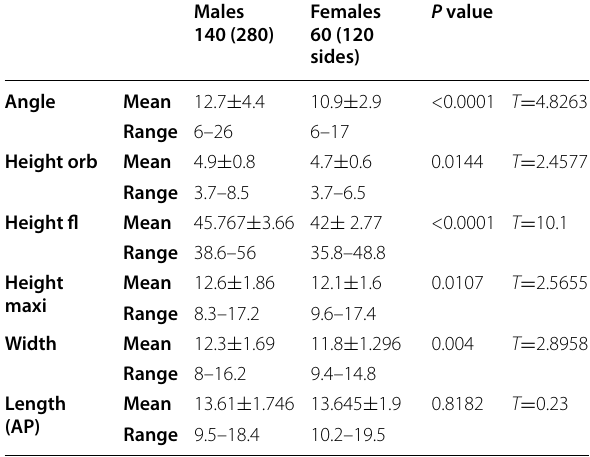
Table 2 Differences between males and